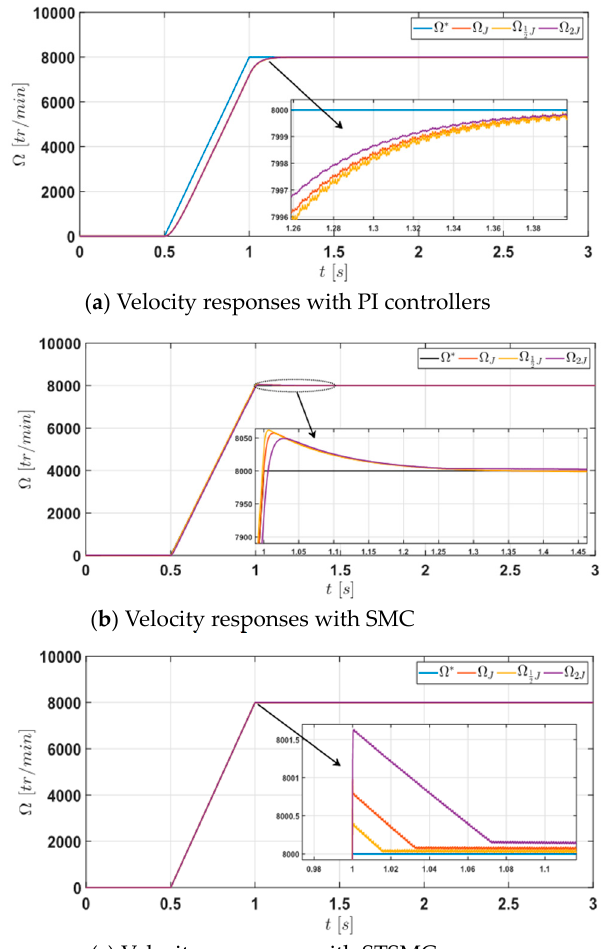
Figure 8. Velocity responses with the three controllers.